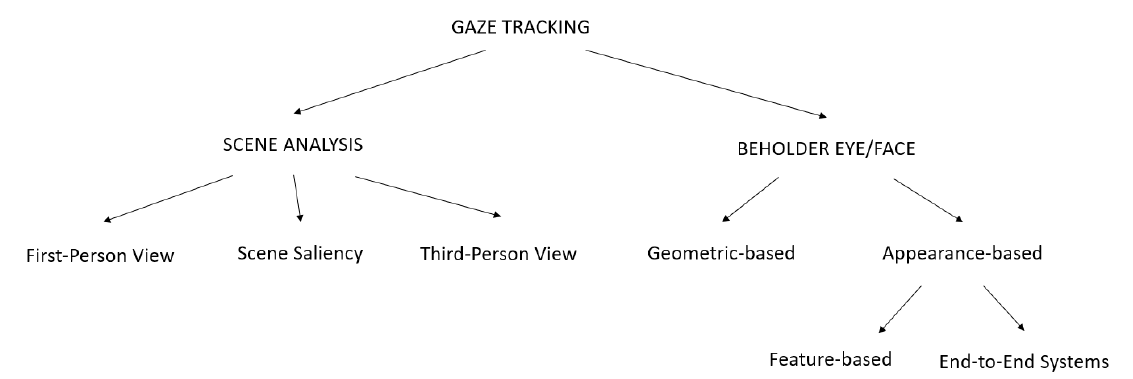
Figure 3. The new proposed taxonomy for categorizing gaze tracking techniques. It considers two different branches related to what is framed in the acquired image: the eye/face of the beholder or the scene observed by